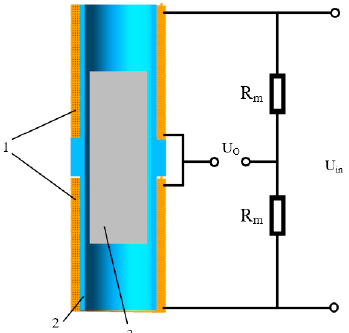
Figure 2. Working principle of the double ‐ coil inductive displacement transducer. (1) Coil, (2) skeleton, and (3) sensing core. 3. Electromagnetic and Electrical Characteristics of Double ‐ Coil Inductive Displace ‐ ment Transducers